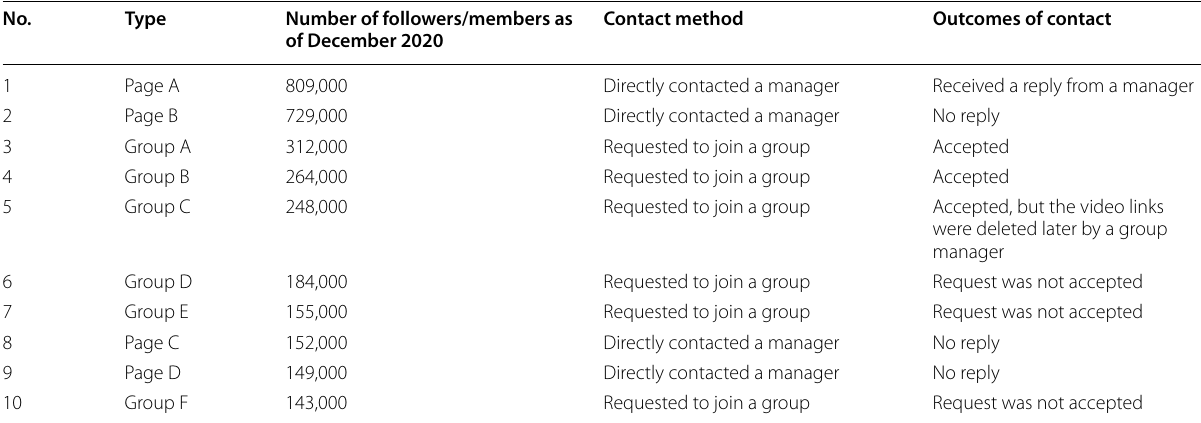
Table 5 List of Facebook groups and pages for Vietnamese people living in Japan